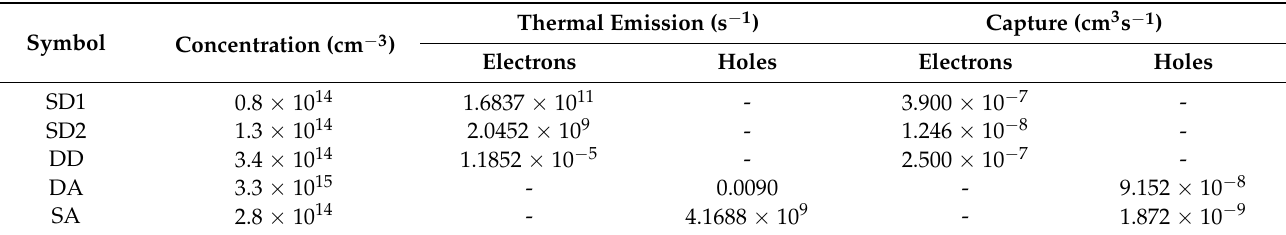
Table 2. Parameters of the coefficients adopted to solve the kinetics